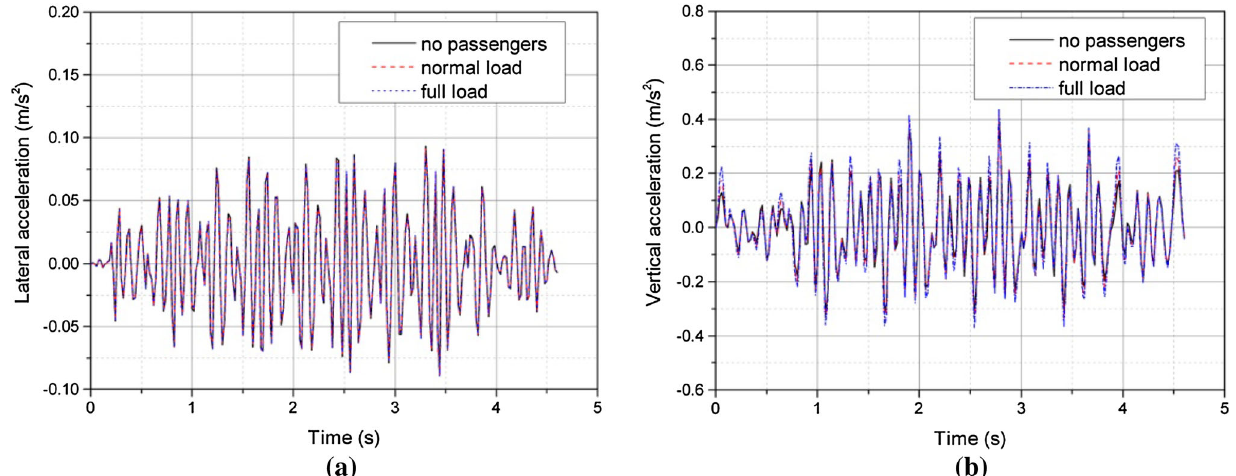
Fig. 13 Record of acceleration at middle span (unit: m/s 2 ). a Lateral, b